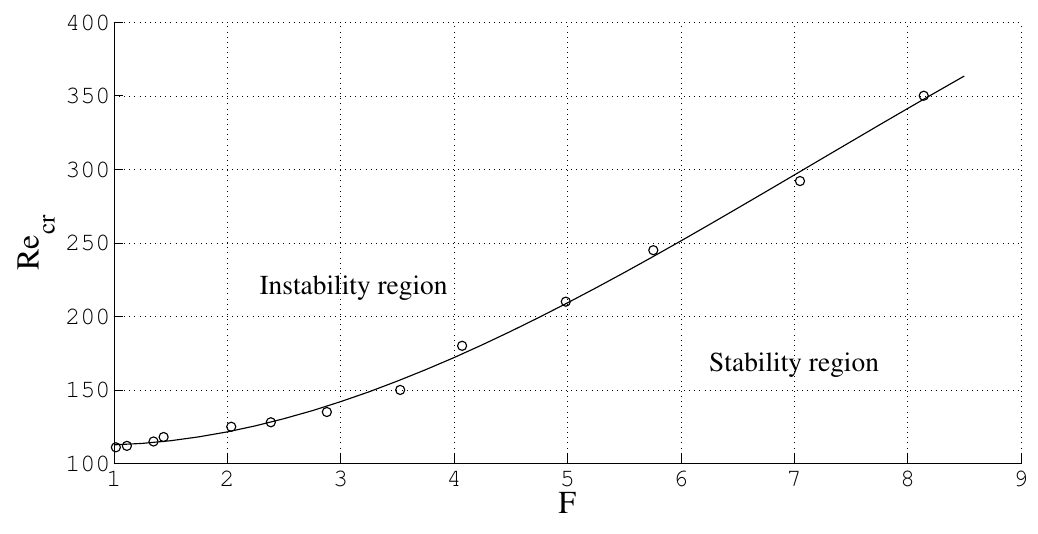
Figure 11. Variation of critical Reynolds number with F for η = 0.7 for the varying angular speed case.